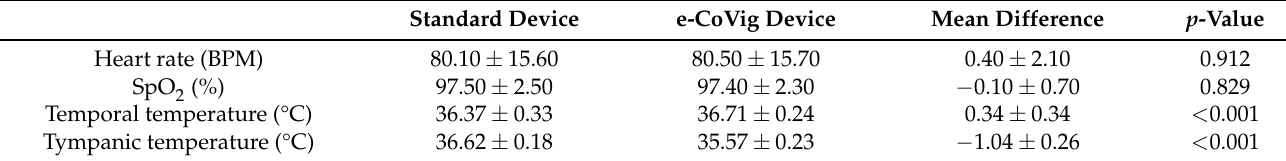
Table 3. Pairwise comparison between the e-CoVig and the standard device measurements.